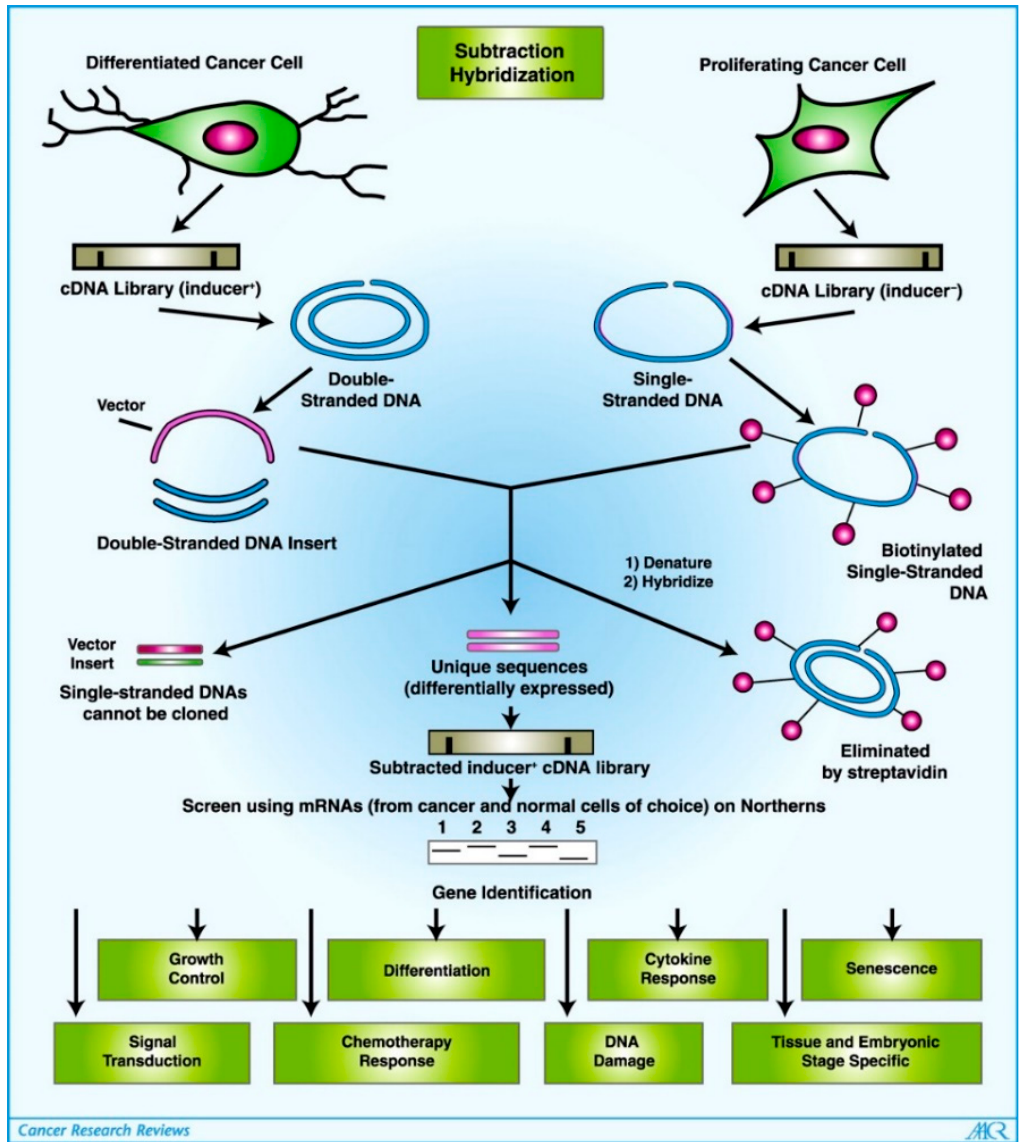
Figure 1. Subtraction hybridization identifies MDA-7/IL-24 . Schematic of DISH (differentiation induction subtraction hybridization), an approach for identifying and cloning genes associated with the induction of terminal differentiation in human melanoma cells. Treatment of HO-1 human melanoma cells with a combination of IFN- β + mezerein results in a rapid and irreversible loss of proliferation, extinction of tumorigenic potential, and terminal differentiation [12–16]. The DISH approach was developed to identify and clone genes associated with and causative of the physiologic changes associated with terminal differentiation. mRNAs were isolated from actively proliferating and IFN- β + mezerein (2000 units/mL + 10 ng/mL)-treated HO-1 cells that span the